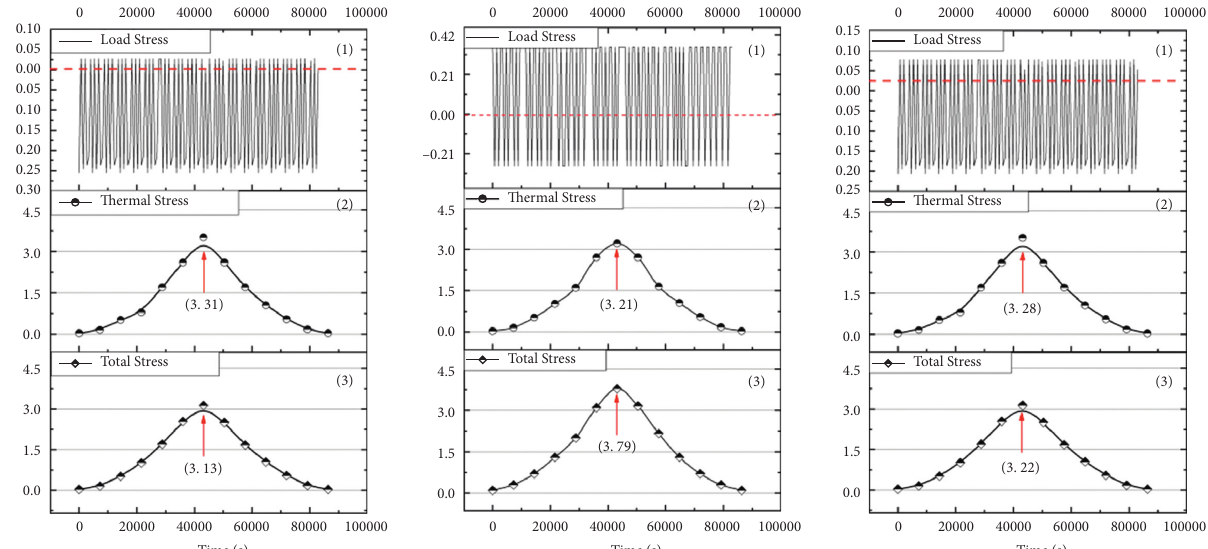
Figure 14: Maximum tensile stress (MPa) at slab corner under the coupling of thermal and traffic loads in summer: (a) “normal” condition, (b) “void” condition, and (c) “polymer” condition.